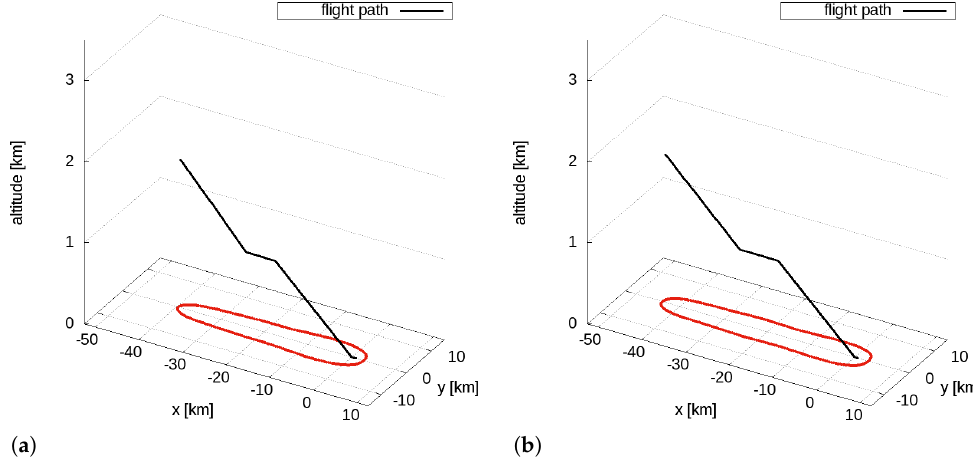
Figure 3. Flight path and 60 dBA isolevel for the reference approach manoeuvre. ( a ) single–aisle aircraft and ( b ) twin–aisle